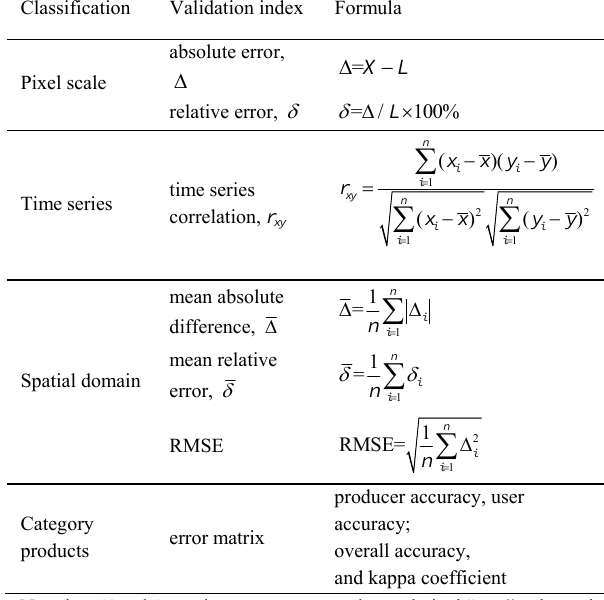
Table 1. Required information for different sampling models